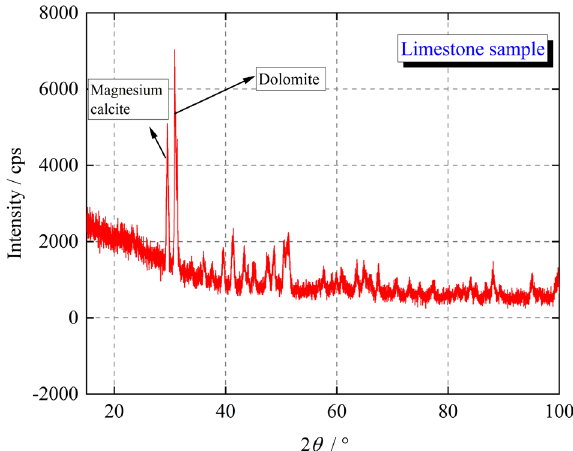
Figure 1. XRD test results of limestone